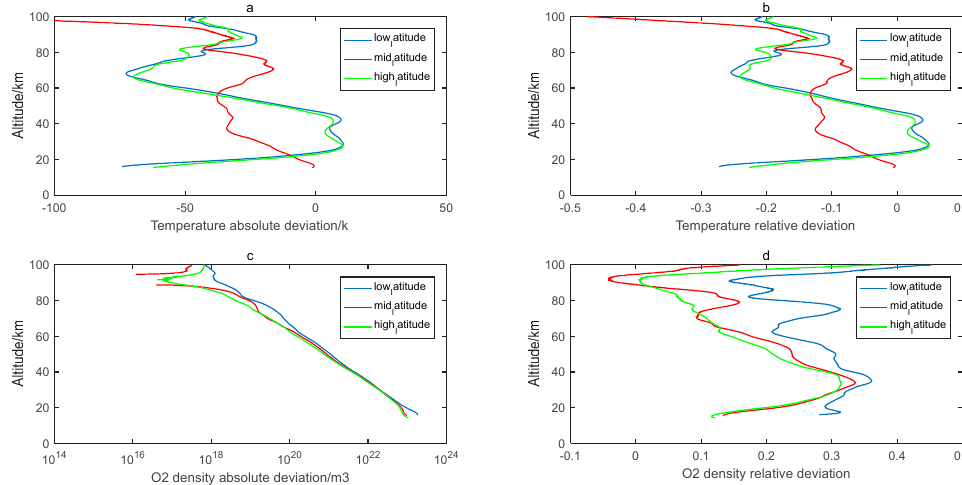
Figure 12. Absolute and relative deviations of temperature in ( a ) and ( c ) respectively. Absolute and relative deviations of oxygen number density at different latitudes in ( b ) and ( d ) respectively.